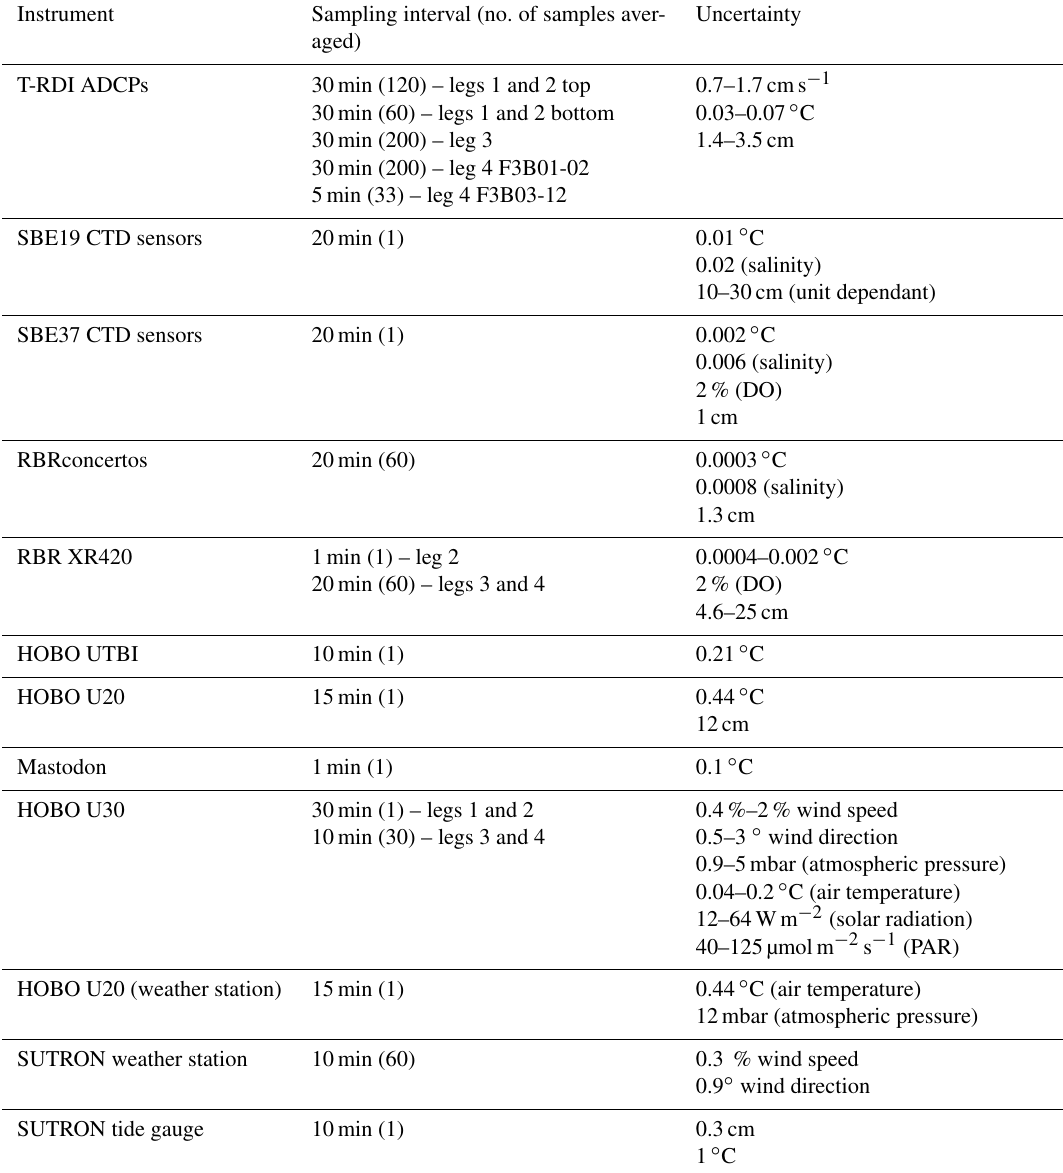
Table 1. Instrumentation used, sampling setup and stated uncertainty (i.e. noise) based on manufacturer specification and sampling setup. “Top” and “bottom” refer to ADCP position on the mooring line during legs 1 and 2 (about 50m vs. 145m depth,